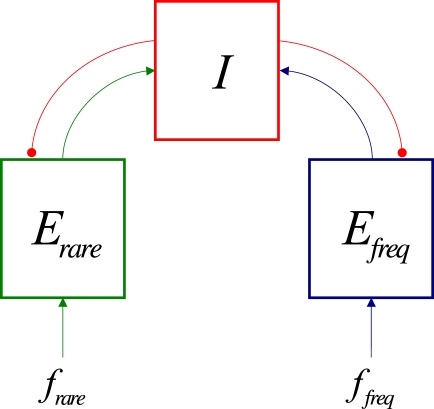
Diagram of Dual Site Stimulation ModelStimulation effect on the excitatory populations is local, and therefore there is stronger depression of that population at the frequent site. The effect on the inhibitory resource, however, is global due to its interconnectivity so it is affected by stimulation at all sites. Thus, response to the rare site may be increased due to the global decline in inhibition.